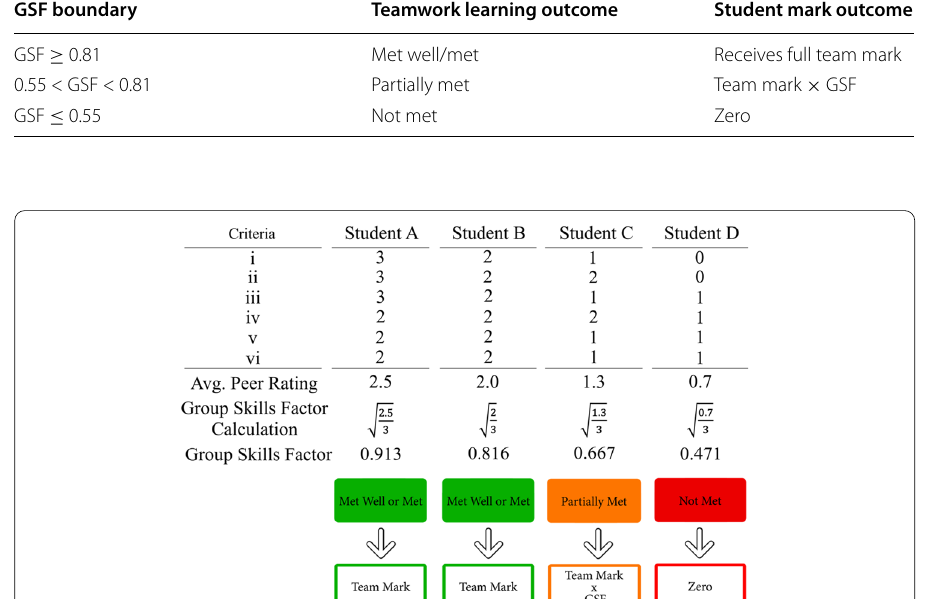
Fig. 3 Individualisation process, from the average peer rating per criterion to the final suggested adjustment for each group skills factor (GSF)